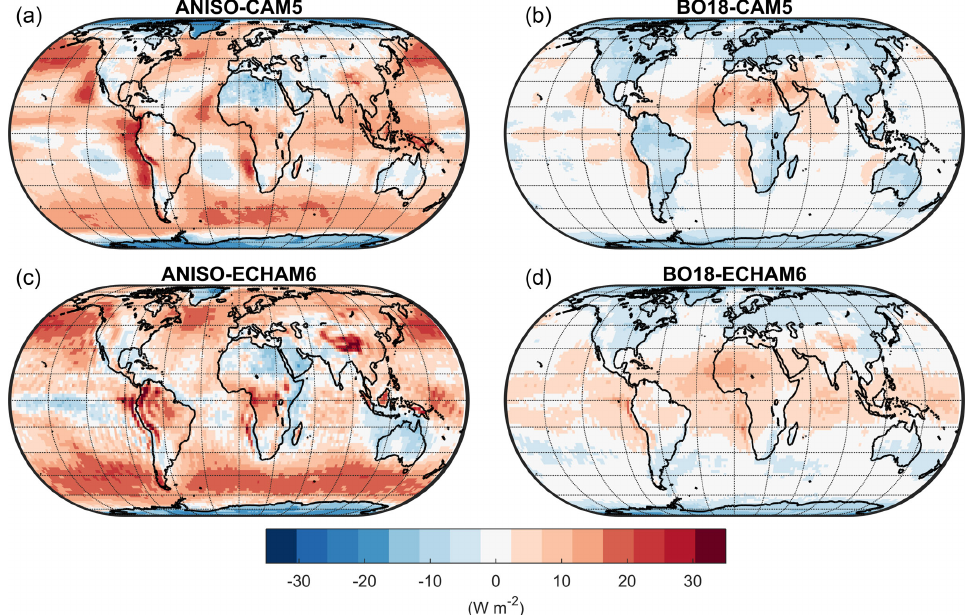
Figure 3. (a) Mean annual bias of the CAM5 albedo change kernel emulated with the ANISO semiempirical model; (b) mean annual bias of the CAM5 albedo change kernel emulated with the BO18 parameterization; (c) mean annual bias of the ECHAM6 albedo change kernel emulated with the ANISO semiempirical model; (d) mean annual bias of the ECHAM6 albedo change kernel emulated with the BO18 parameterization.